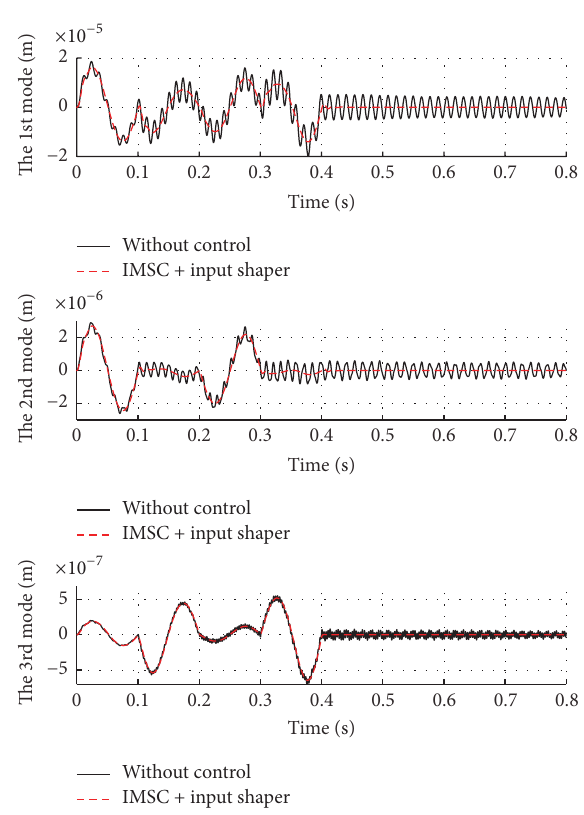
Figure 4: The first three modes’ vibration response at three-quarters of the first